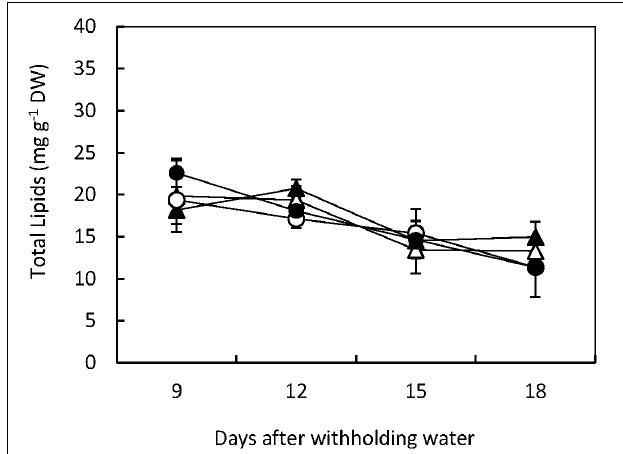
FIGURE 1 | Total Lipids. Total lipids were quantified in drought susceptible Flega (triangles) and resistant Patones (circles) well-watered plants (open symbols) and during a time course of water stress (solid symbols) (9, 12, 15, and 18 days). Data are mean of five replicates ± standard